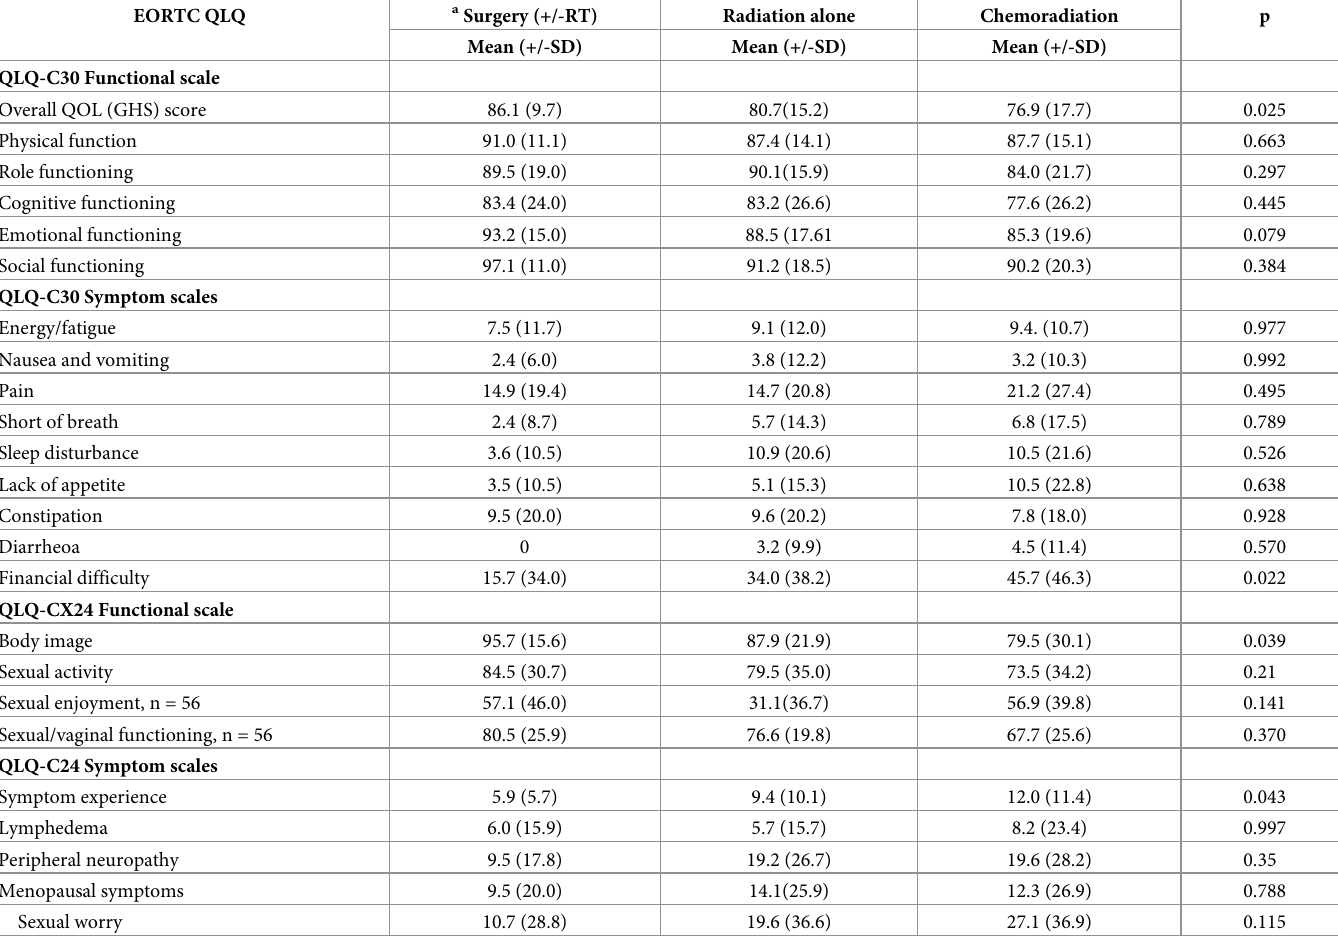
Table 4. EORTC QLQ C-30 and QLQ CX-24 domains and treatment type received by the survivors. EORTC QLQ